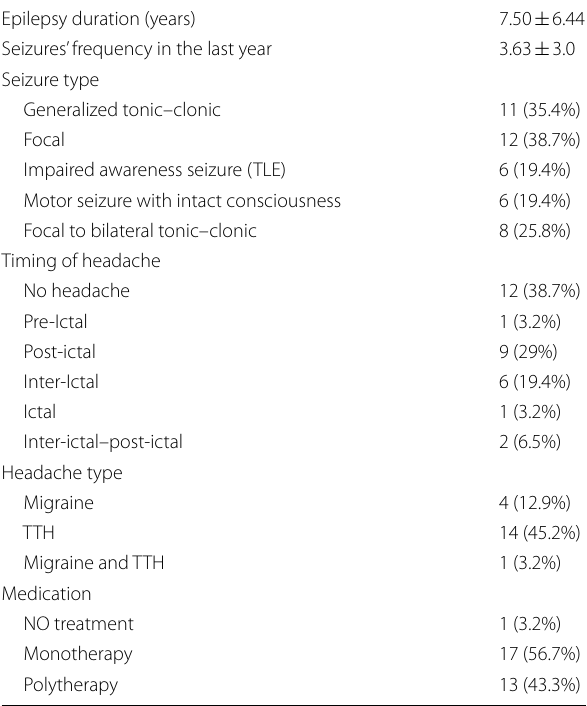
Table 2 Characteristics relevant to epilepsy and headaches